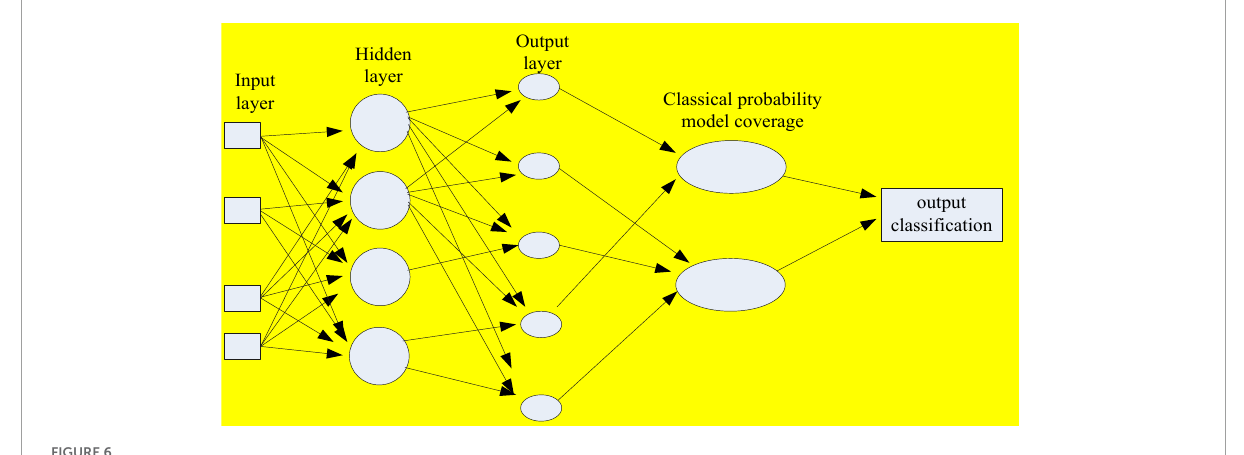
FIGURE6 Bayesian probabilistic model classification learning internal model.